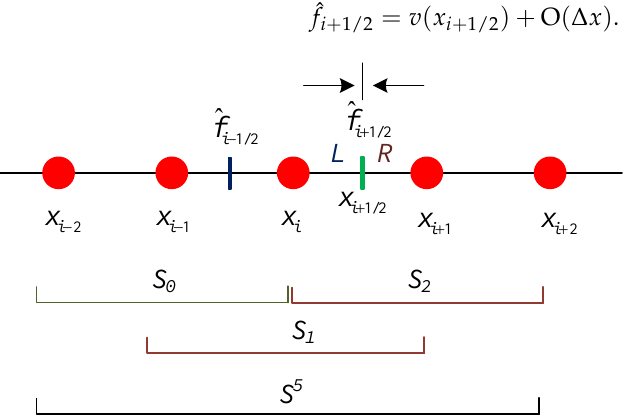
Figure 1. Schematic of the 1-D spatial discretization; 5-points stencil S 5 composed of three 3-points stencils S 0 , S 1 , S 2